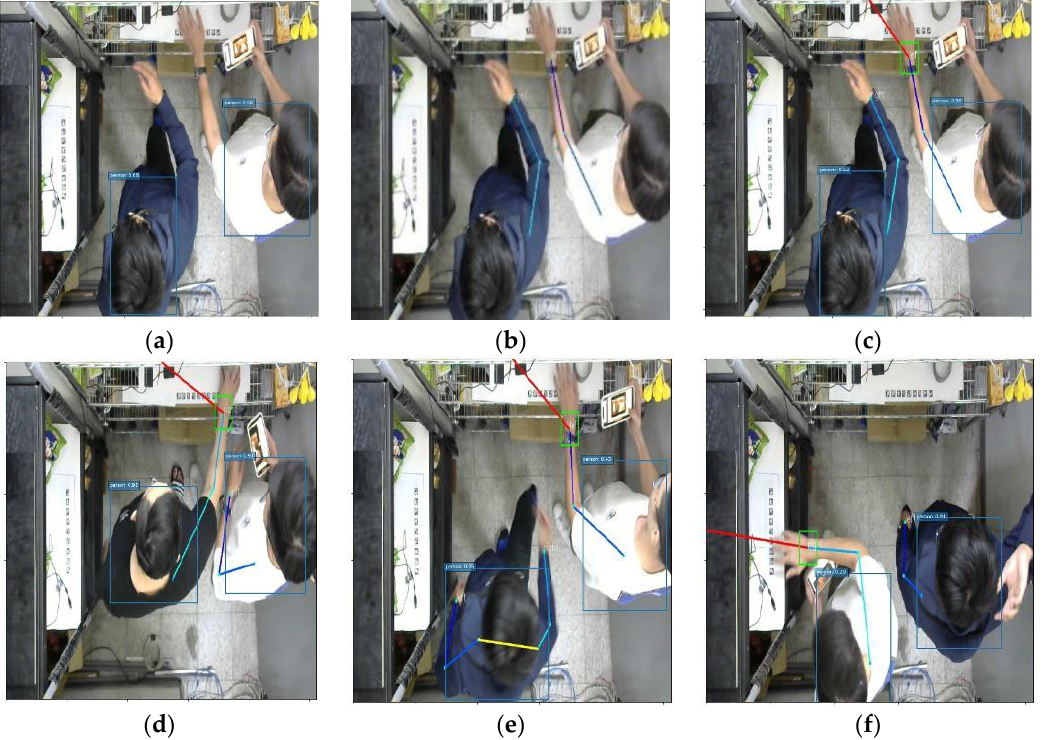
Figure 7. ( a ) Person detection; ( b ) OpenPose; ( c ) find the customer; ( d ) triggered behind; ( e ) trig- gered front; ( f ) no trigger. front; ( f ) no